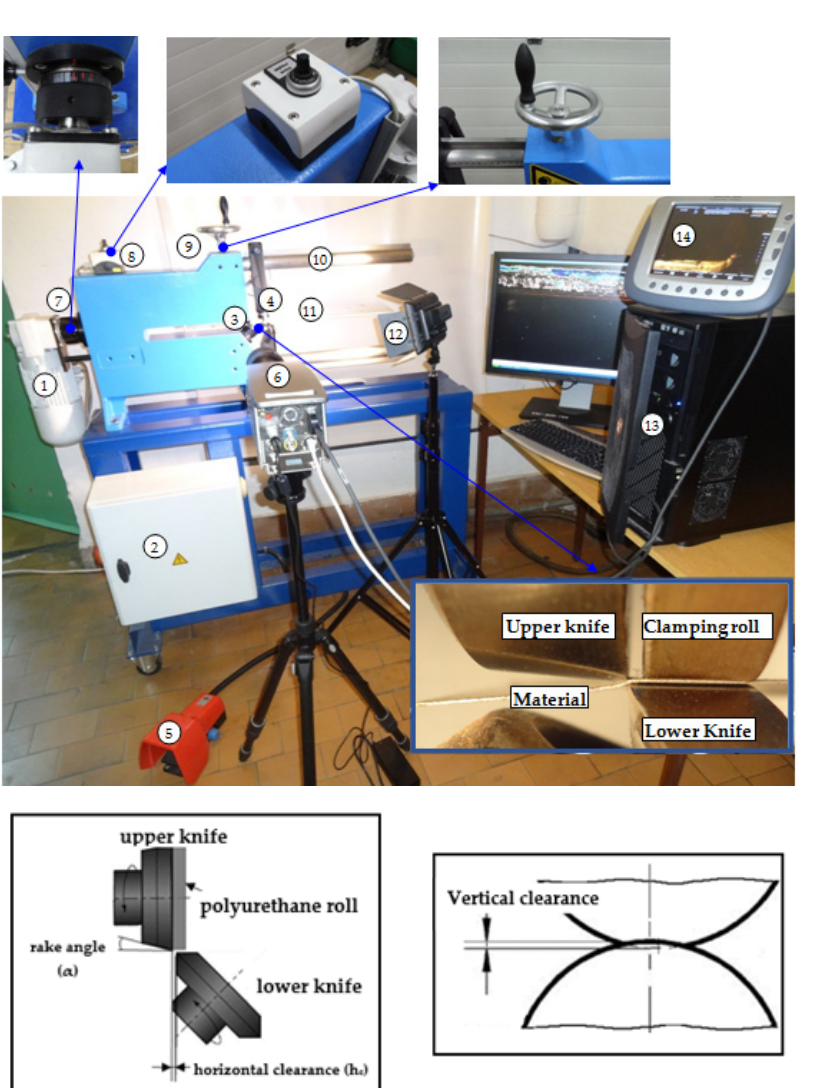
Materials 2022 , 15 , 8824 7 of 22